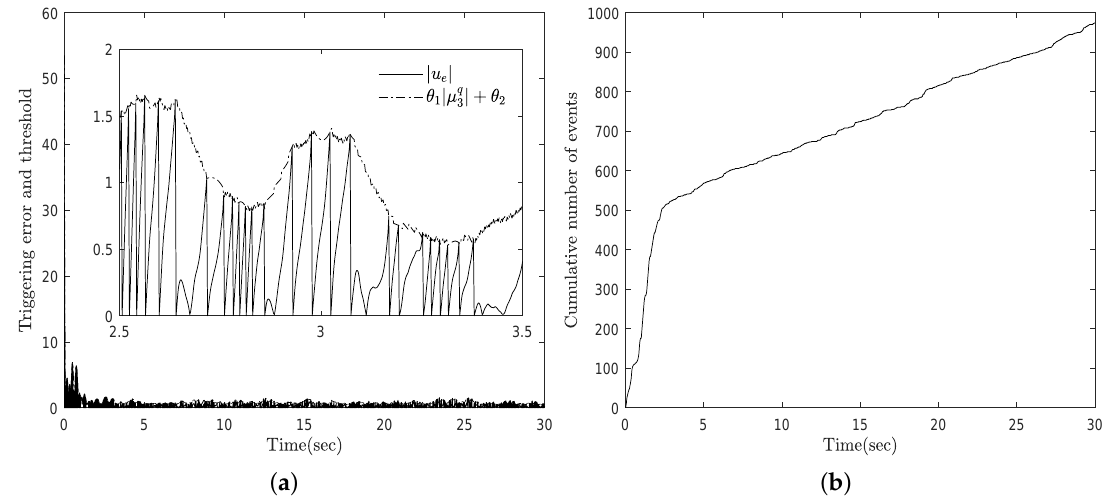
Figure 5. Triggering threshold and the comparison of the cumulative number of events of the proposed approach for Example 1 ( a ) | u e | and θ 1 | µ q